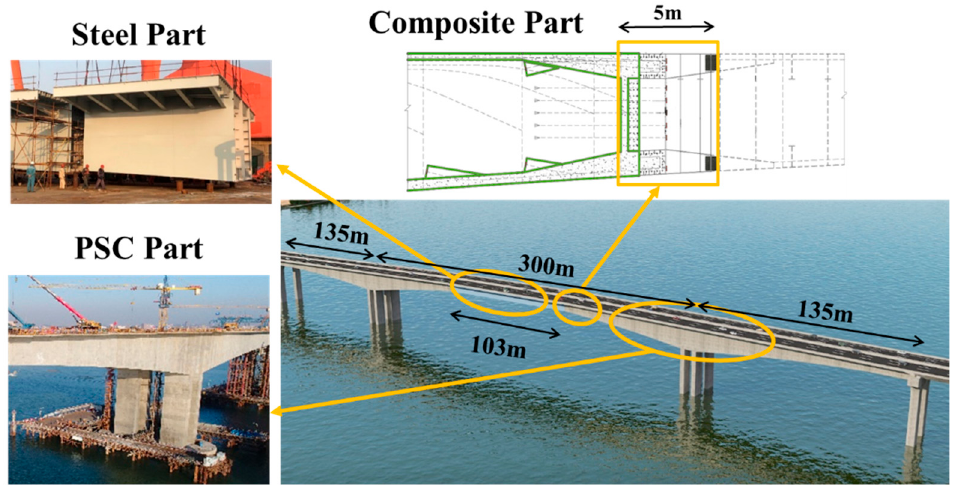
Figure 2. Configuration of Anhai Bay Bridge.